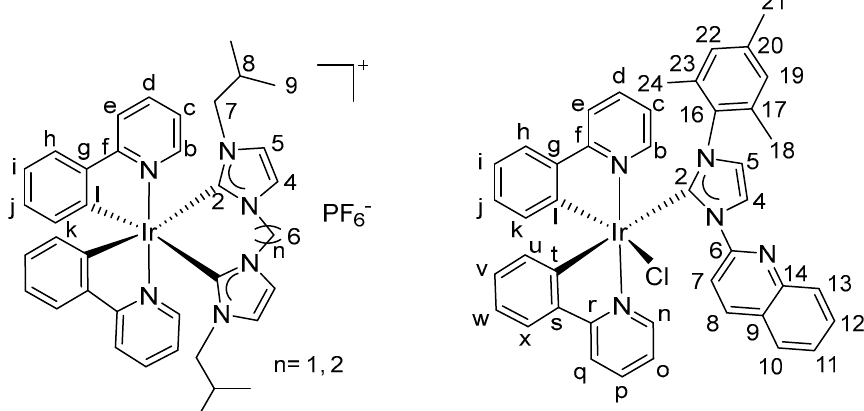
Figure 15. Numbering of H ( 1 H NMR) and C ( 13 C NMR) used for the NMR attributions.